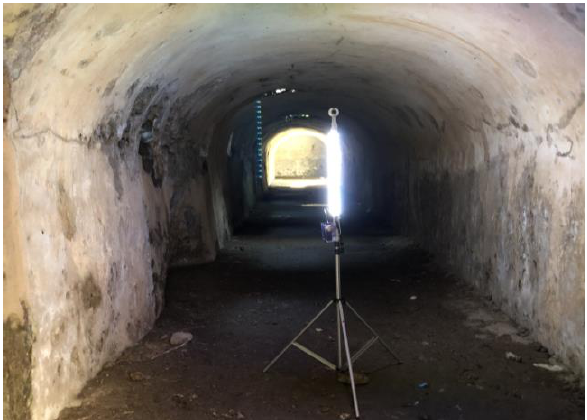
Figure 6. Composite system used for the acquisition of spherical images